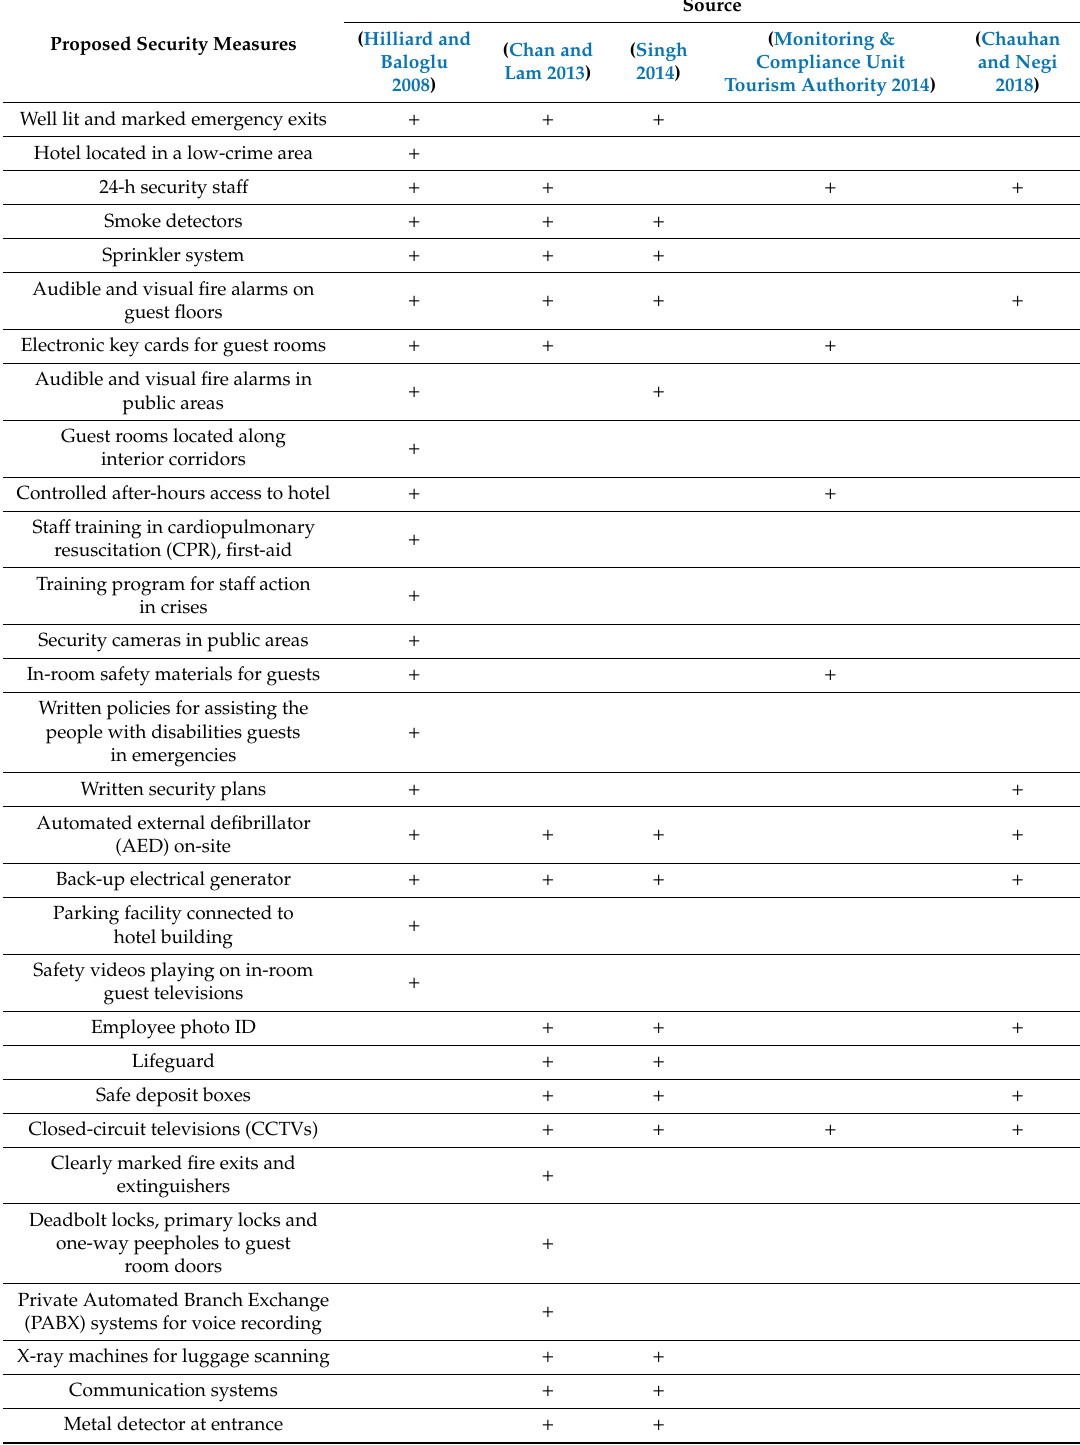
Table 1. Literature review of the range of security measures used at accommodation facilities.